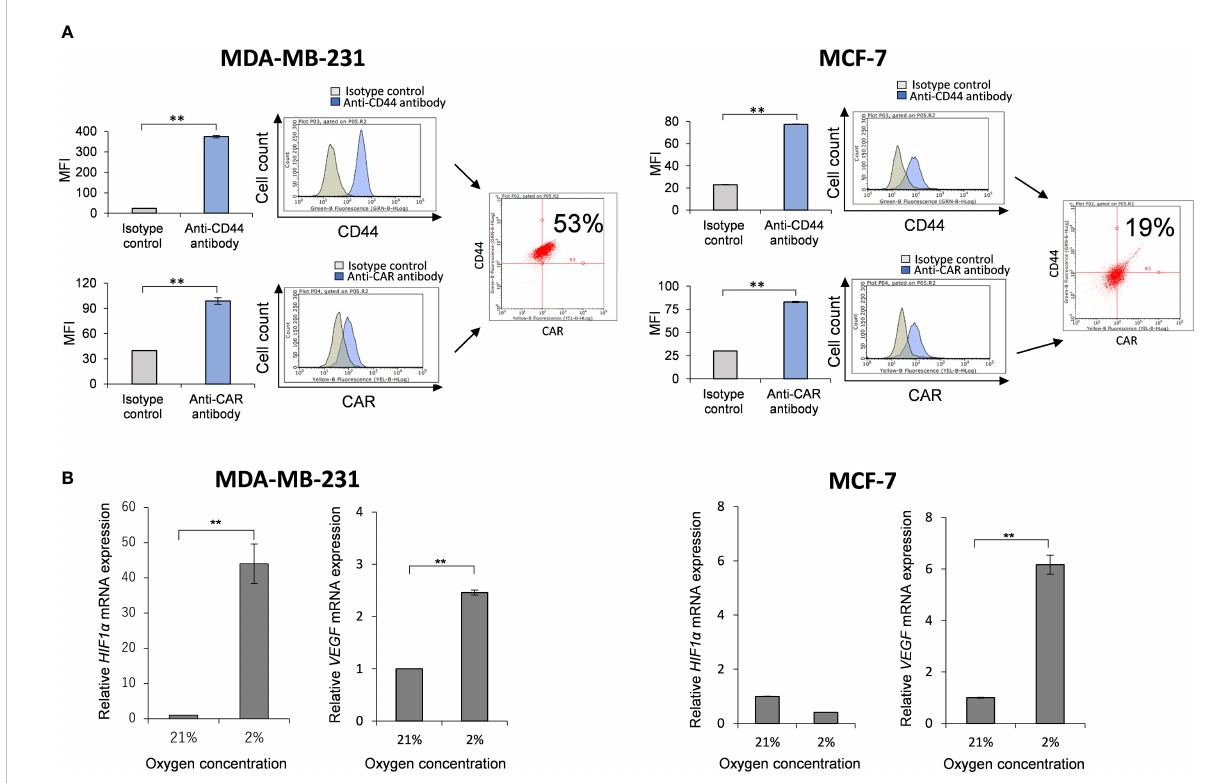
FIGURE 2 Expressions of CAR and CD44, and induction of HIF-1 a mRNA by hypoxia in MDA-MB-231 and MCF-7 cells (A) The expressions of CAR and CD44 on the cell surface of MDA-MB-231 and MCF-7 cells were determined by fl ow cytometry. Mean fl uorescence intensities (MFI) and their representative histograms are shown. Both CAR and CD44 expressions were signi fi cantly higher than their isotype controls (n=3, average ± SE bars, **p< 0.01). However, the CD44 expression in MCF-7 was relatively lower than MDA-MB-231 cells. The upper right corner of the histogram represents CD44 and CAR double positive cells. (B) The mRNA expressions of HIF-1 a and VEGF in MDA-MB-231 and MCF-7 cells were measured by real-time RT-PCR under the culture conditions of O 2 concentrations of 21% and 2%. The mRNA levels of HIF-1 a and VEGF in MDA-MB-231 cells were signi fi cantly increased in 2% hypoxia culture condition compared to 21% condition. In addition, mRNA level of HIF-1 a in MCF-7 cells was not increased in hypoxia, while VEGF was signi fi cantly increased in hypoxia (n=3, average ± SE bars, **p<